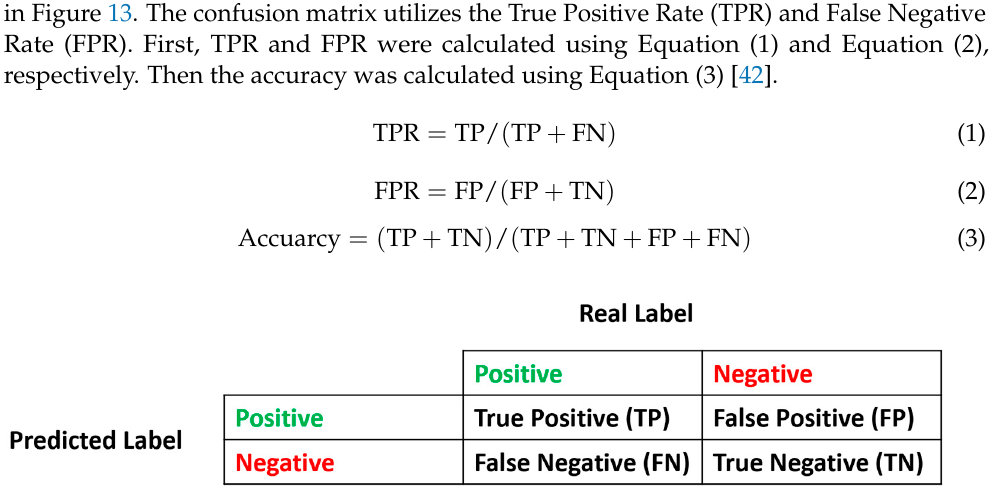
Table 4. Hardware and software description.